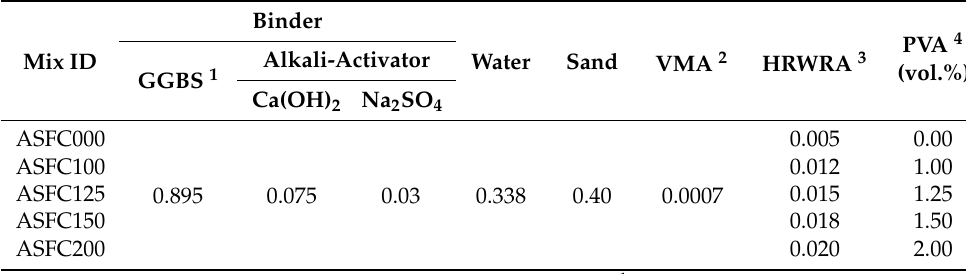
Table 3. Properties of PVA (Polyvinyl alcohol) fiber.